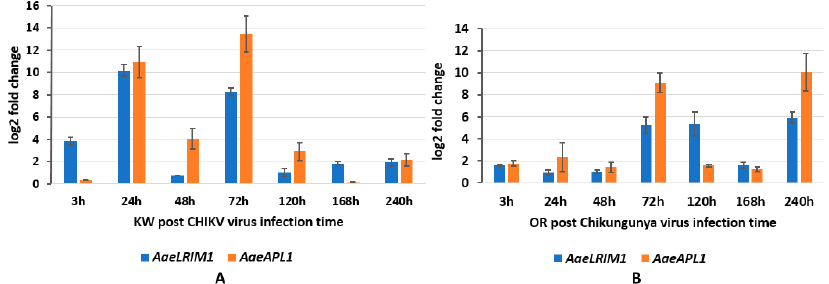
Figure 4. AaeLRIM1 and AaeAPL1 relative expression level fold changes in Aedes aegypti female infected with CHIKV. The fold change was calculated using the 2 [ − average ΔΔ CT] method. Δ Ct (Control) = Ct ( AaeLRIM1 / AaeAPL1 ) − Ct ( AeaActin ); Δ Ct (infected-CHIKV) = Ct ( AaeLRIM1 / AaeAPL1 ) − Ct ( AeaActin ); ΔΔ Ct = Δ Ct (infected-CHIKV) − Δ Ct (Control). The 3, 24, 48, 72, 120, 168, and 240 h represented gene expression post infected with CHIKV. ( A ) Key West strain female Ae. aegypti ; ( B ) Orlando strain female Ae. aegypti .